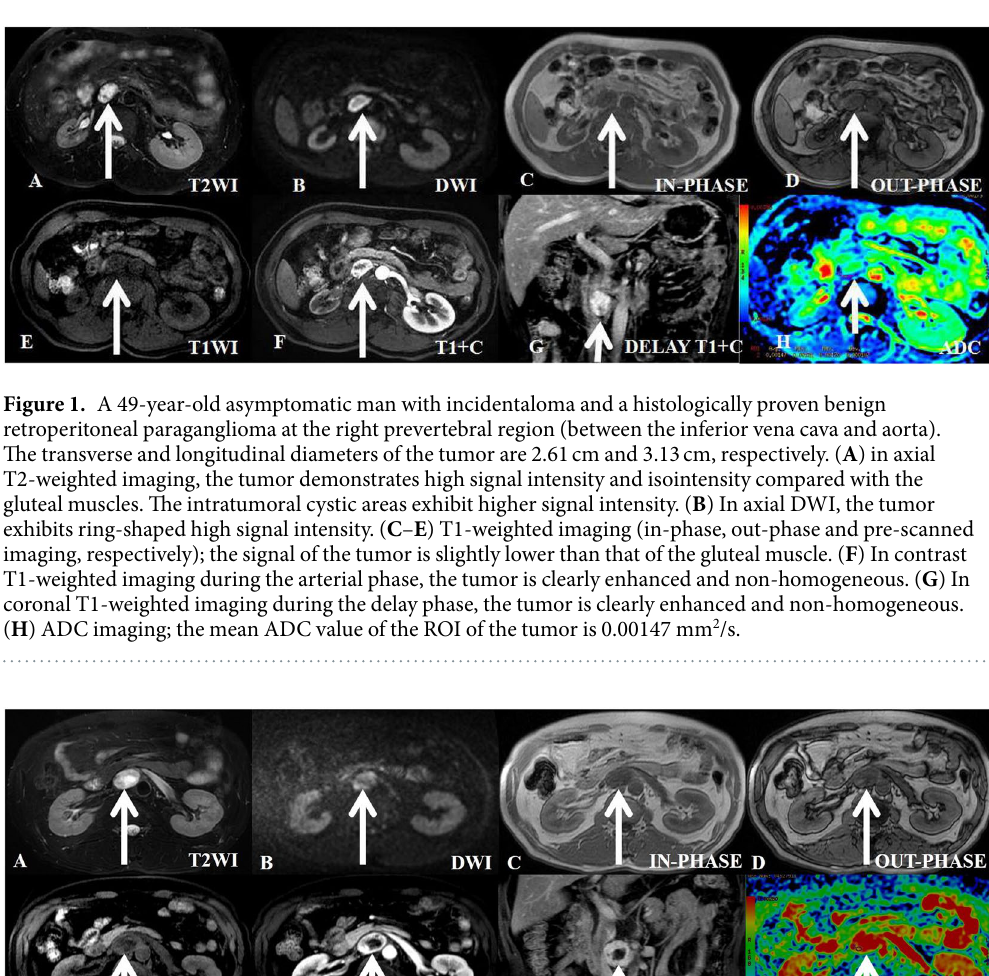
tumors were fully excised in all cases, with clear resection margins. The final histologic diagnosis was obtained by laparoscopic surgery (n = 9), robot-assisted laparoscopic surgery (n = 10), or laparotomy (n = 5). Imaging features in MRI Scans. The presenting quantitative MR imaging characteristics of mean maxi- mum lesion size, diameter ratio and Apparent Diffusion Coefficient (ADC) values of the 24 patients are summa- rized in Table 2; there were no significant differences between the assessments made by the two reviewers. Among the 24 lesions, a maximum diameter greater than 5 cm was observed in 17 cases; in the remaining 7 lesions, the maximum diameter was less than 5 cm.